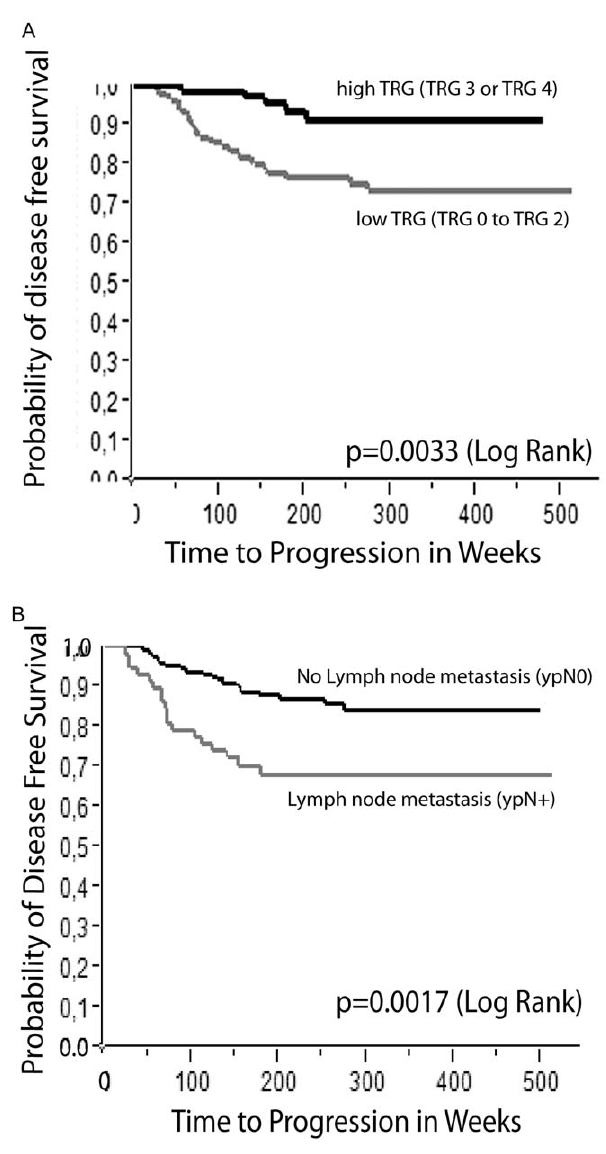
Figure 3. Kaplan Meier diagrams for the time to progression. A. Time to progression in weeks in relation to the probability of progression free survival stratified for a dichotomized tumor regression grading (TRG 0/1/2 = no regression or dominant tumor mass with obvious fibrosis or mucin or dominantly fibrotic or mucinous changes, with tumor cells or groups; TRG 3/4 = very few tumor cells in fibrotic or mucinous tissue or no tumor cells, only fibrotic or mucinous mass / total regression; according to Dworak et al. 1997). B. Time to progression in weeks in relation to the probability of progression free survival stratified for lymph node metastasis (ypN0 and ypN + ).